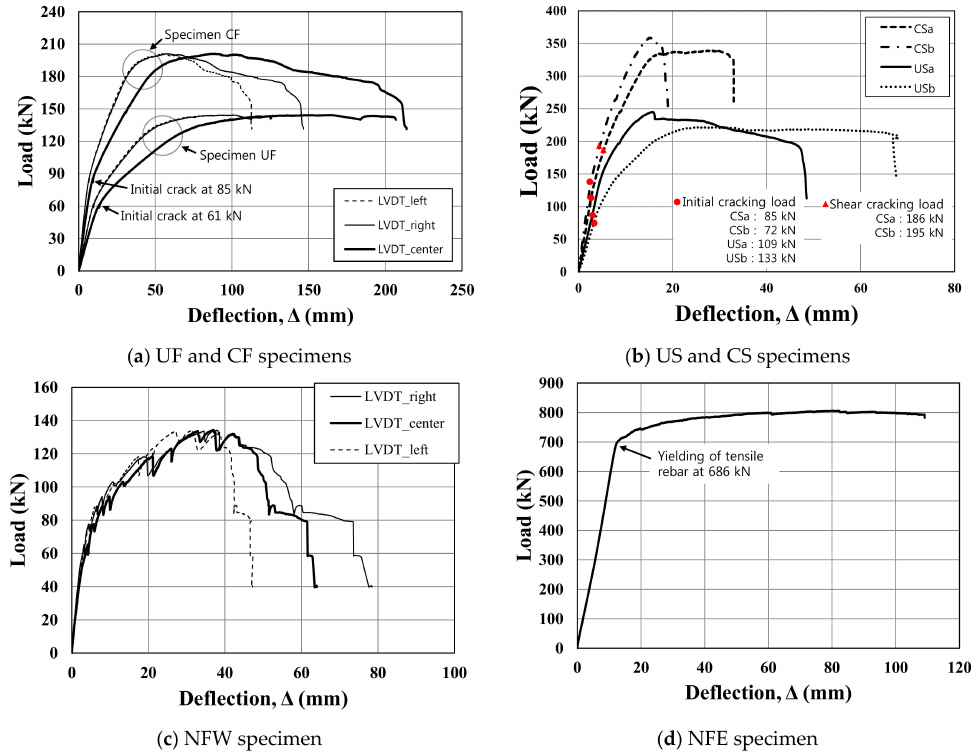
Figure 9. Load-deflection responses.